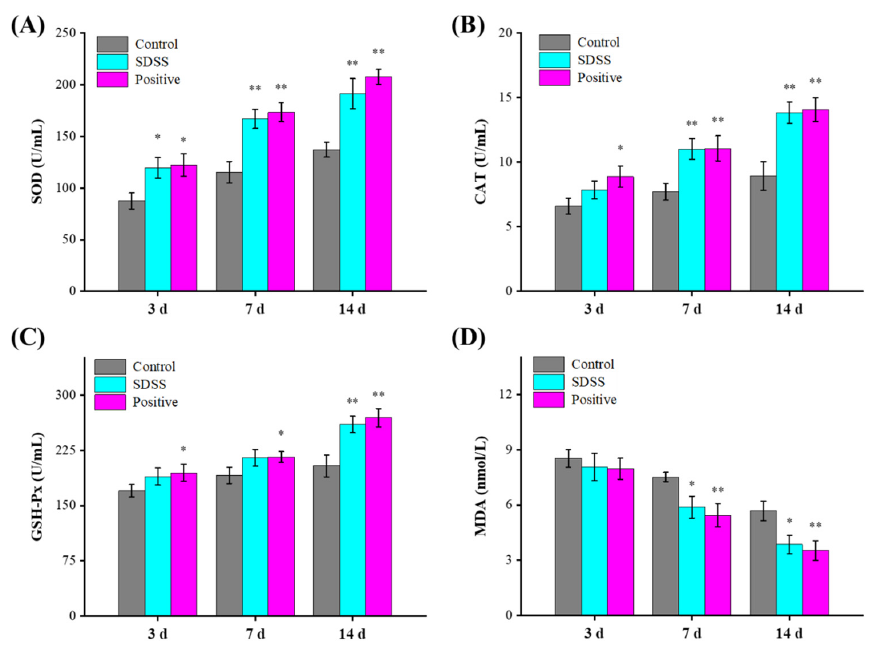
Figure 5. Effect of SDSS on serum SOD ( A ), CAT ( B ), GSH-Px ( C ) activities, and MDA ( D ) levels ( n = 5). * p < 0.05, ** p < 0.01 when compared to the control group.